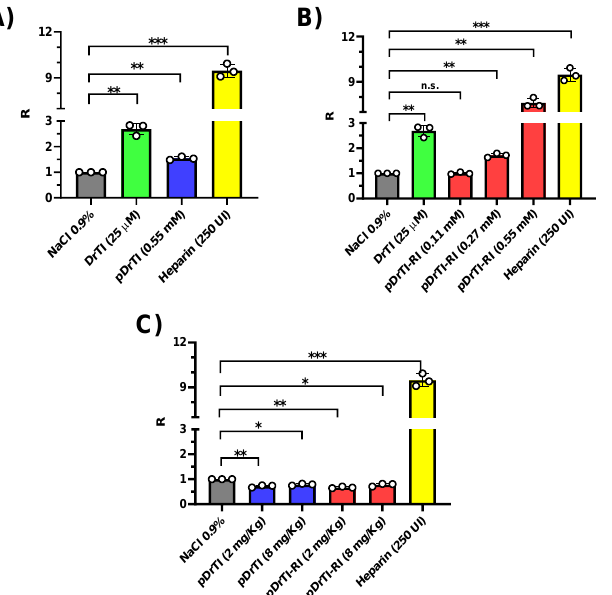
Figure 2. aPTT tests—Coagulation assay (aPTT) performed in vitro with human plasma in a Dade Behring semiautomatic coagulometer. PPP was incubated with pDrTI ( A ) or pDrTI-RI ( B ) in the presence of cephalin. After incubation, 0.02% CaCl 2 was added and the time for fibrin clot formation was recorded. ( C ) Coagulation assay ex vivo. Animals were pre-treated by retro-orbital injection with the substances 30 min prior to euthanasia. Whole blood was collected by cardiac puncture with 3.8% sodium citrate, 1:9, and centrifuged to obtain PPP. Then, a coagulation assay was performed in a Dade Behring semiautomatic coagulometer. R = Ratio between the clotting time of the com- pounds under study and the control. Assays were performed in triplicate. Statistical analysis was made using t -test with W elch’s correction using GraphPad Prism 8. n.s.: non -significant; * p < 0.05; ** p < 0.01; *** p < 0.001. The inhibitory activity of the pDrTI-RI peptide on intrinsic coagulation pathway en- zymes and possibly FXIa was determined in the plasma inhibition assay. When ex vivo aPTT tests were performed, none of the peptides were able to change the clot formation time (Figure 2C) at the analyzed concentrations. We hypothesize that this is due to the fact that the concentration used for the ex vivo aPTT experiments is higher than the concen- trations used for the other in vivo tests and is significantly lower than the concentrations used in the in vitro tests. There were no changes in aPTT in vitro at concentrations similar to those used in the in vivo assays. 3.3. Platelet Aggregation